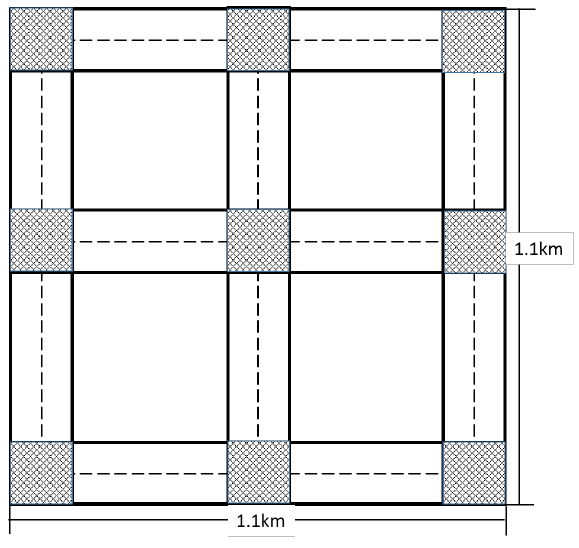
Figure 9. Simulation